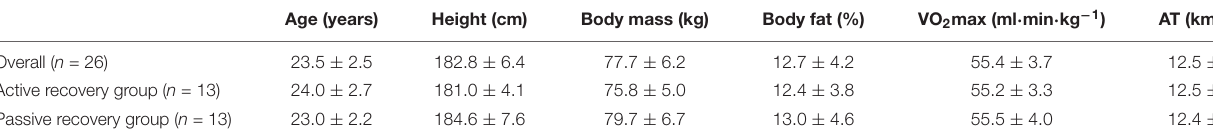
TABLE 1 | Baseline physical characteristics of the athletes.